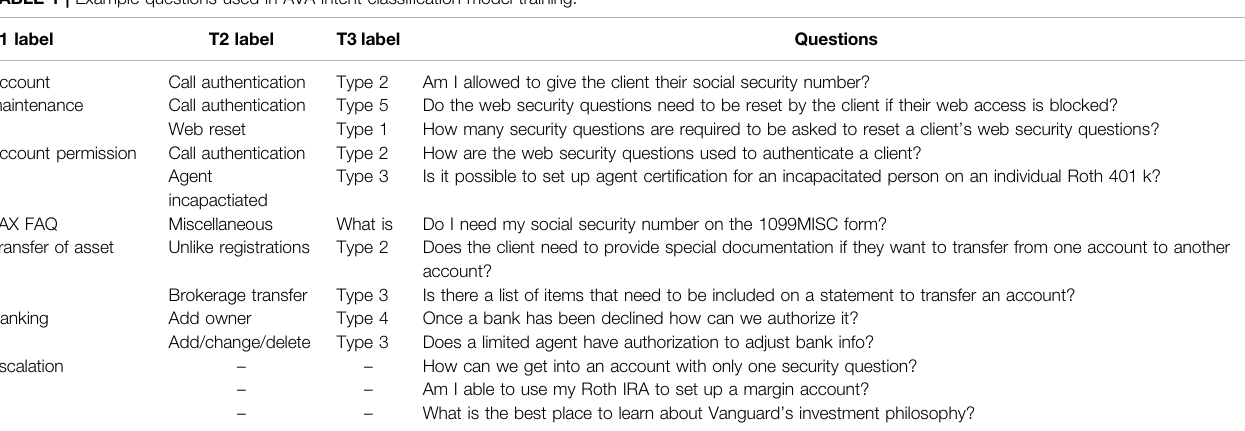
TABLE 1 | Example questions used in AVA intent classi fi cation model training.